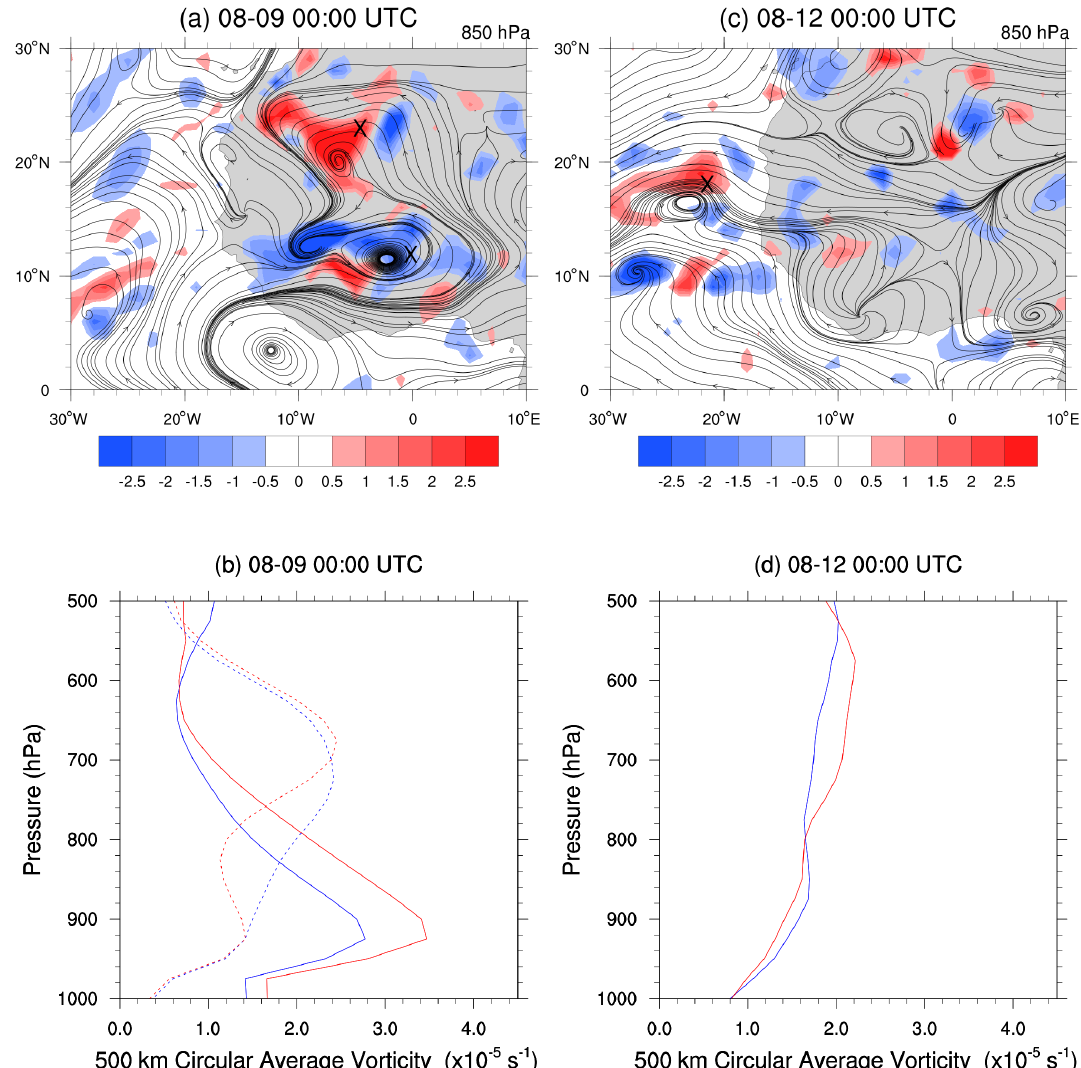
Figure 8. As in Fig. 7 but for the evolution of the AEW associated with Harvey on 9 August (a,b) and 12 August (c,d) . The horizontal panels (a,b) show 850hPa CTL streamlines and 850hPa AER–CTL cyclonic vorticity differences, instead of 700hPa, to better capture the two-vortex signal. Over Africa (b) , we overlaid the vertical vorticity structures of the northern (solid) and southern (dotted) vorticities for CTL (blue) and AER